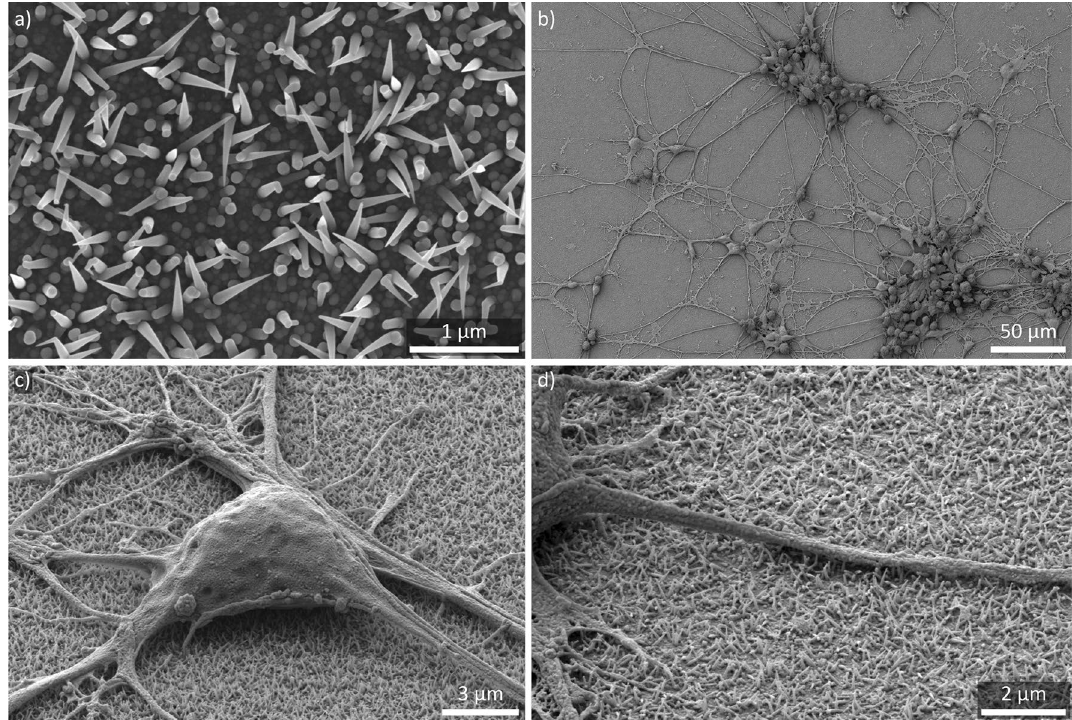
Figure 1. SEM images of a NW sample and human iPSC-derived neurons cultured on NWs. ( a ) Top view of the utilized NW substrate. The NW density is about 600 NWs/100 µm 1 µm featuring a gradually tapered shape. ( b ) Top view of a neuronal network formed by human iPSC-derived neurons on a NW substrate. ( c ) Cell soma of a human iPSC-derived neuron cultured on NWs. Tilt is 54°. ( d ) Close-up view of a neurite growing on NWs. Tilt is 54°.